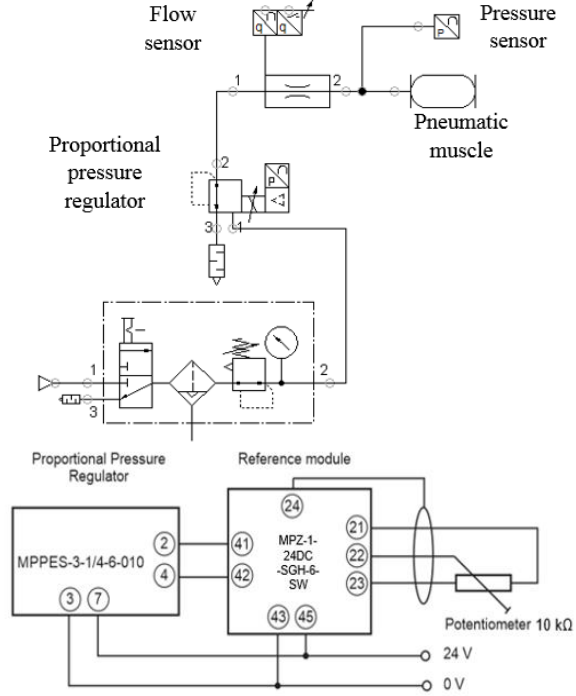
Figure 14. Control of the rehabilitation equipment by means of a proportional pressure regulator.